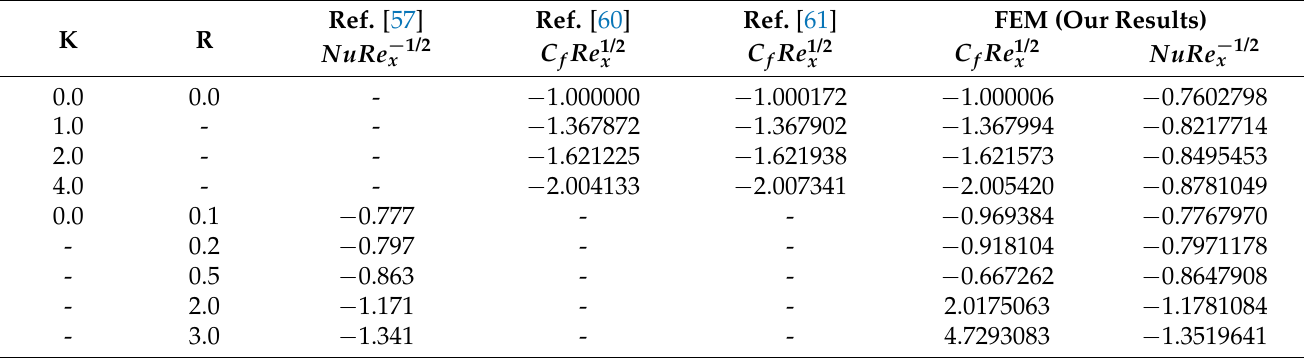
Table 3. Comparison of C f Re 1/2 x and NuRe − 1/2 x for various values of R and K , when Pr = 1.5 and not considering other involved parameters.